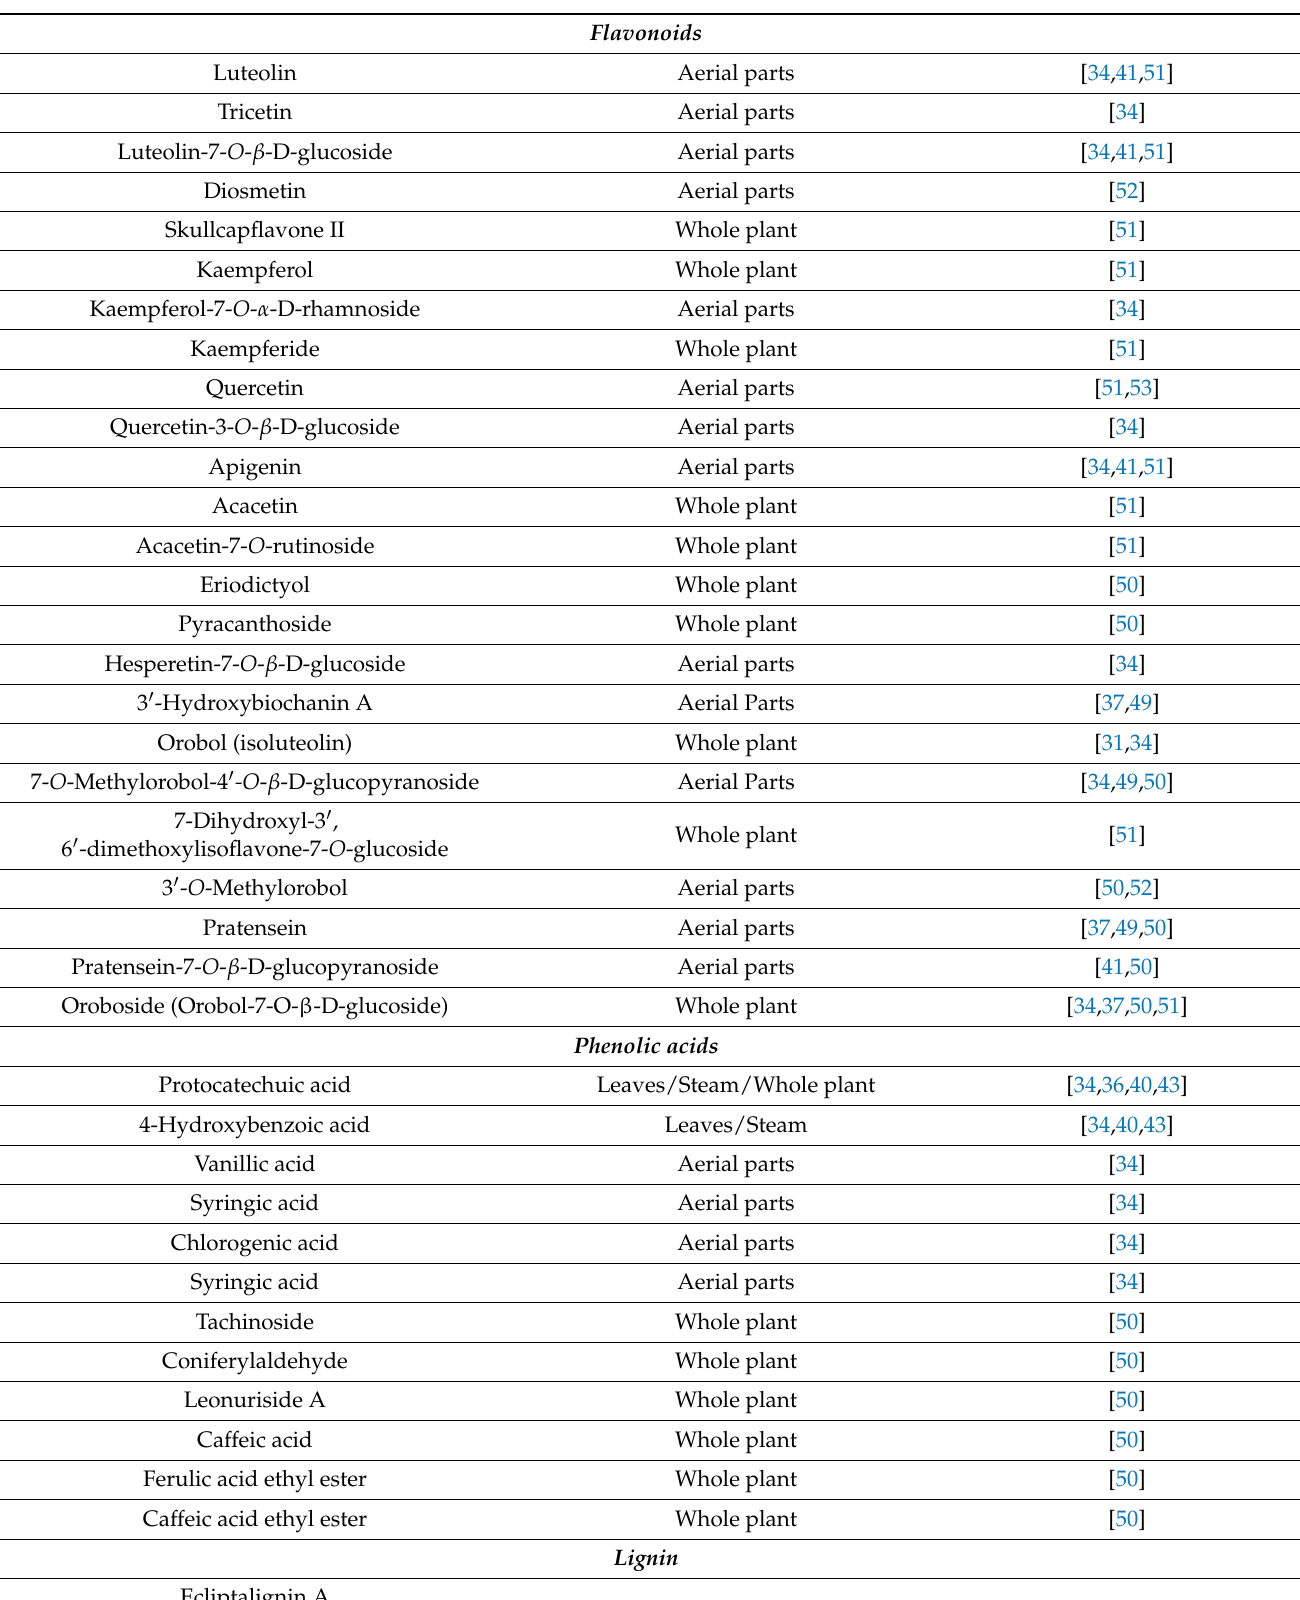
Table 2. Flavonoids, phenolic acids, substituted thiophines, and other compounds present in the E. prostrata